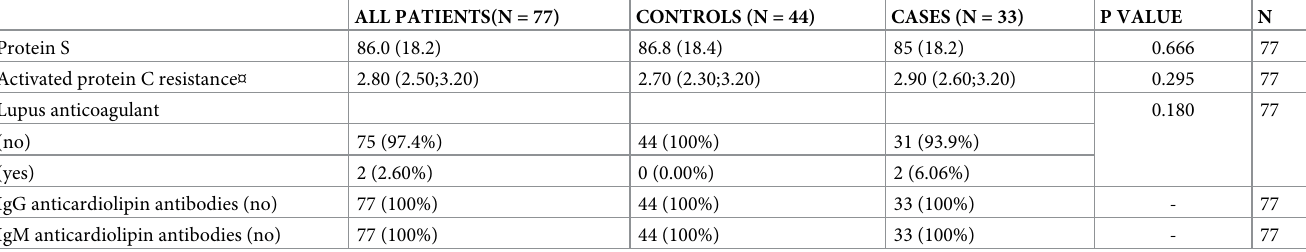
Table 2. Results of standard blood tests for thrombophilias in cases and